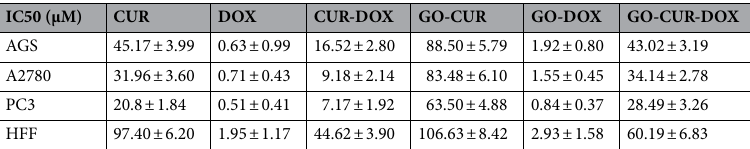
Table 1. The IC50 values of DOX and CUR on AGS, PC3, A2780 and HFF cells after 48 h.